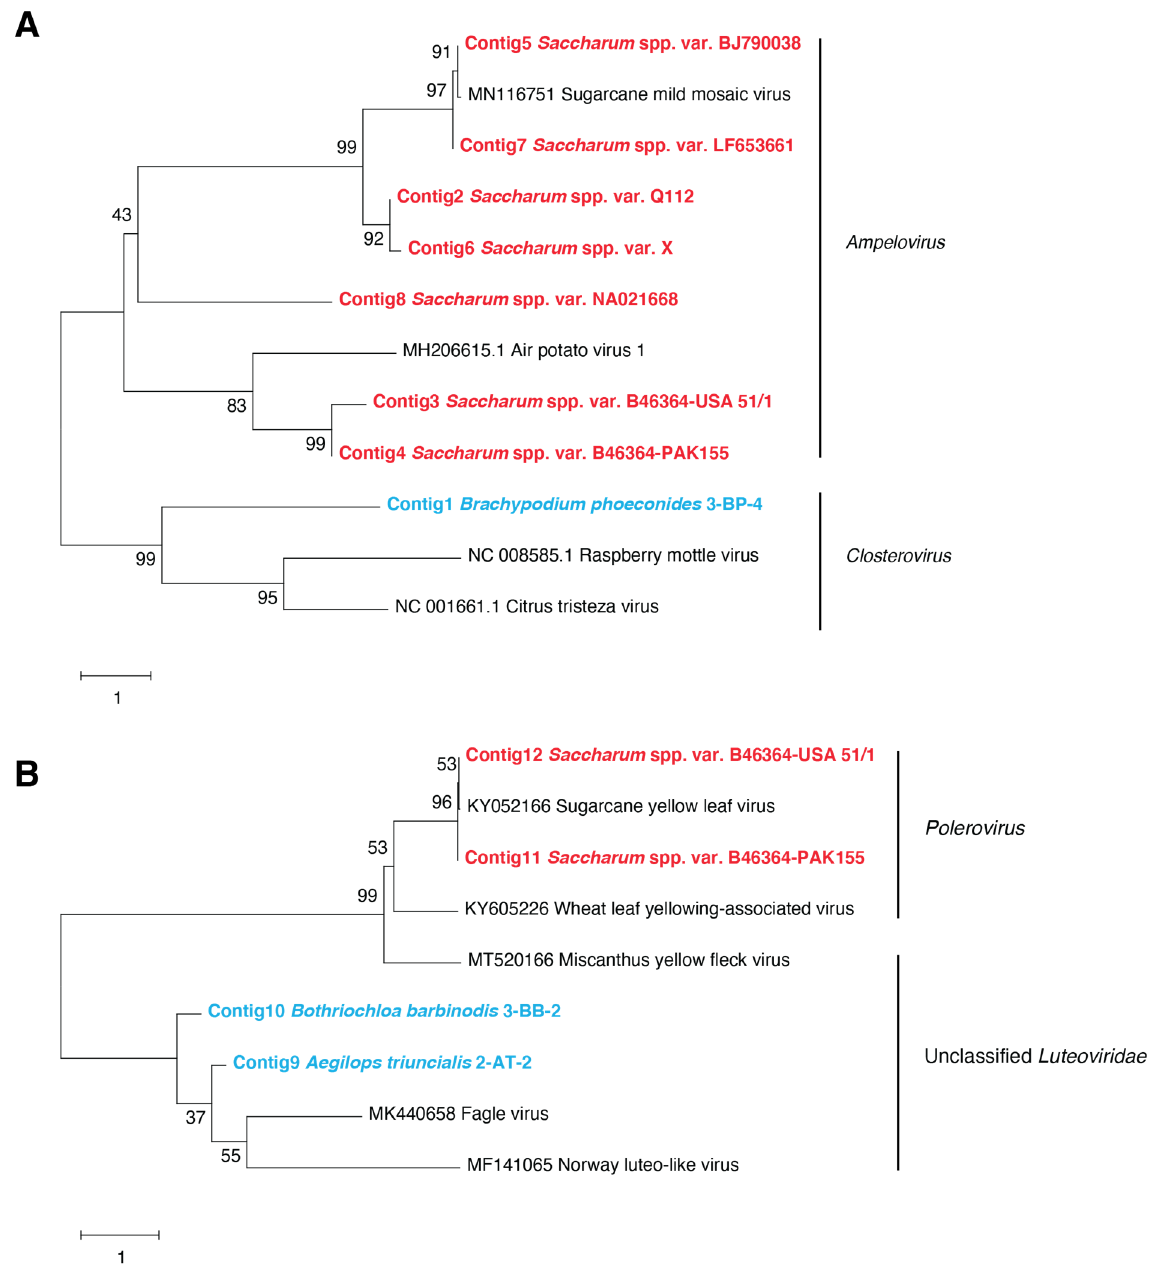
Figure 2. ( A ) Neighbor-joining phylogenetic tree of Closteroviridae contigs obtained from one wild Poaceae species (bold characters colored in blue), sugarcane varieties (bold characters colored in red), and representative closteroviruses and ampeloviruses genome sequences (colored in black). ( B ) Neighbor-joining phylogenetic tree of Luteoviridae contigs obtained from two wild Poaceae species (bold characters colored in blue), two plants from one sugarcane variety (bold characters colored in red), and representative Luteoviridae genome sequences (colored in black). Scale bars represent the number of substitutions per site; branch labels correspond to the consensus support (%). The 12 contigs produced from quarantined sugarcane varieties and wild Poaceae samples, assigned to the Closteroviridae and Luteoviridae families, are listed in the Supplementary Material.